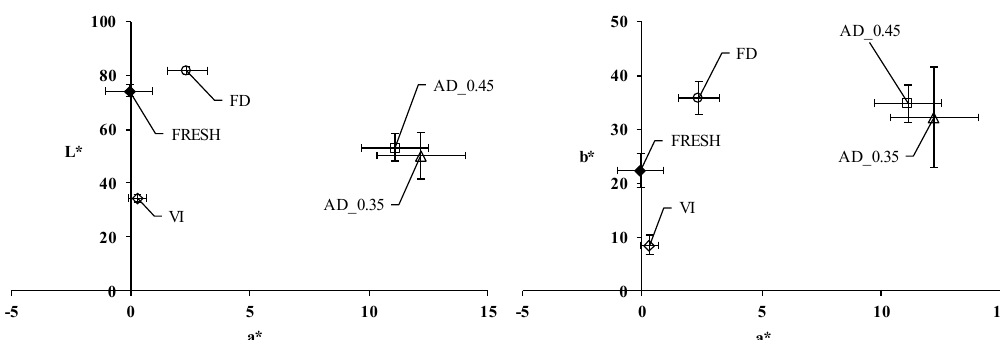
Figure 1. Colorimetric maps (L* vs. a* and b* vs. a*) of fresh apple (FRESH), vacuum-impregnated apple (VI), freeze-dried apple (FD) and air-dried apple at 40 °C until a final water activity of 0.45 (AD_0.45) or 0.35 (AD_0.35). Mean values of samples impregnated with the different impregnation liquids. Error bars represent the standard deviation of three replicates for each one of the different impregnation liquids.